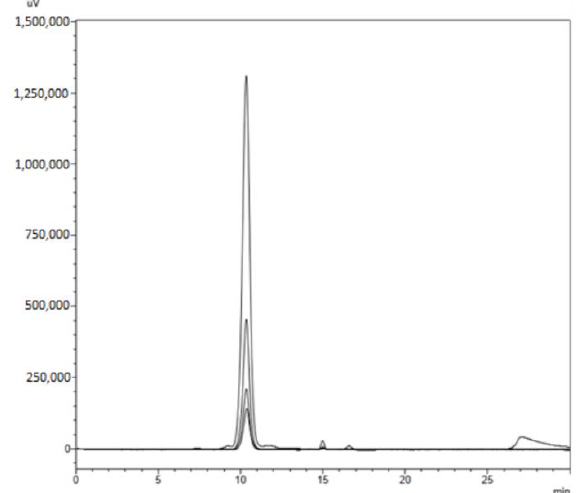
Figure 3. A standard of cGMP (Sigma-Aldrich) was dissolved in 0.1 M PBS at different concentrations and then analyzed by HPLC under the same conditions used to separate and analyze the samples adulterated milk with cheese whey. The dilutions of the standard presented a fine single signal at the same retention time as the adulterated milk samples.